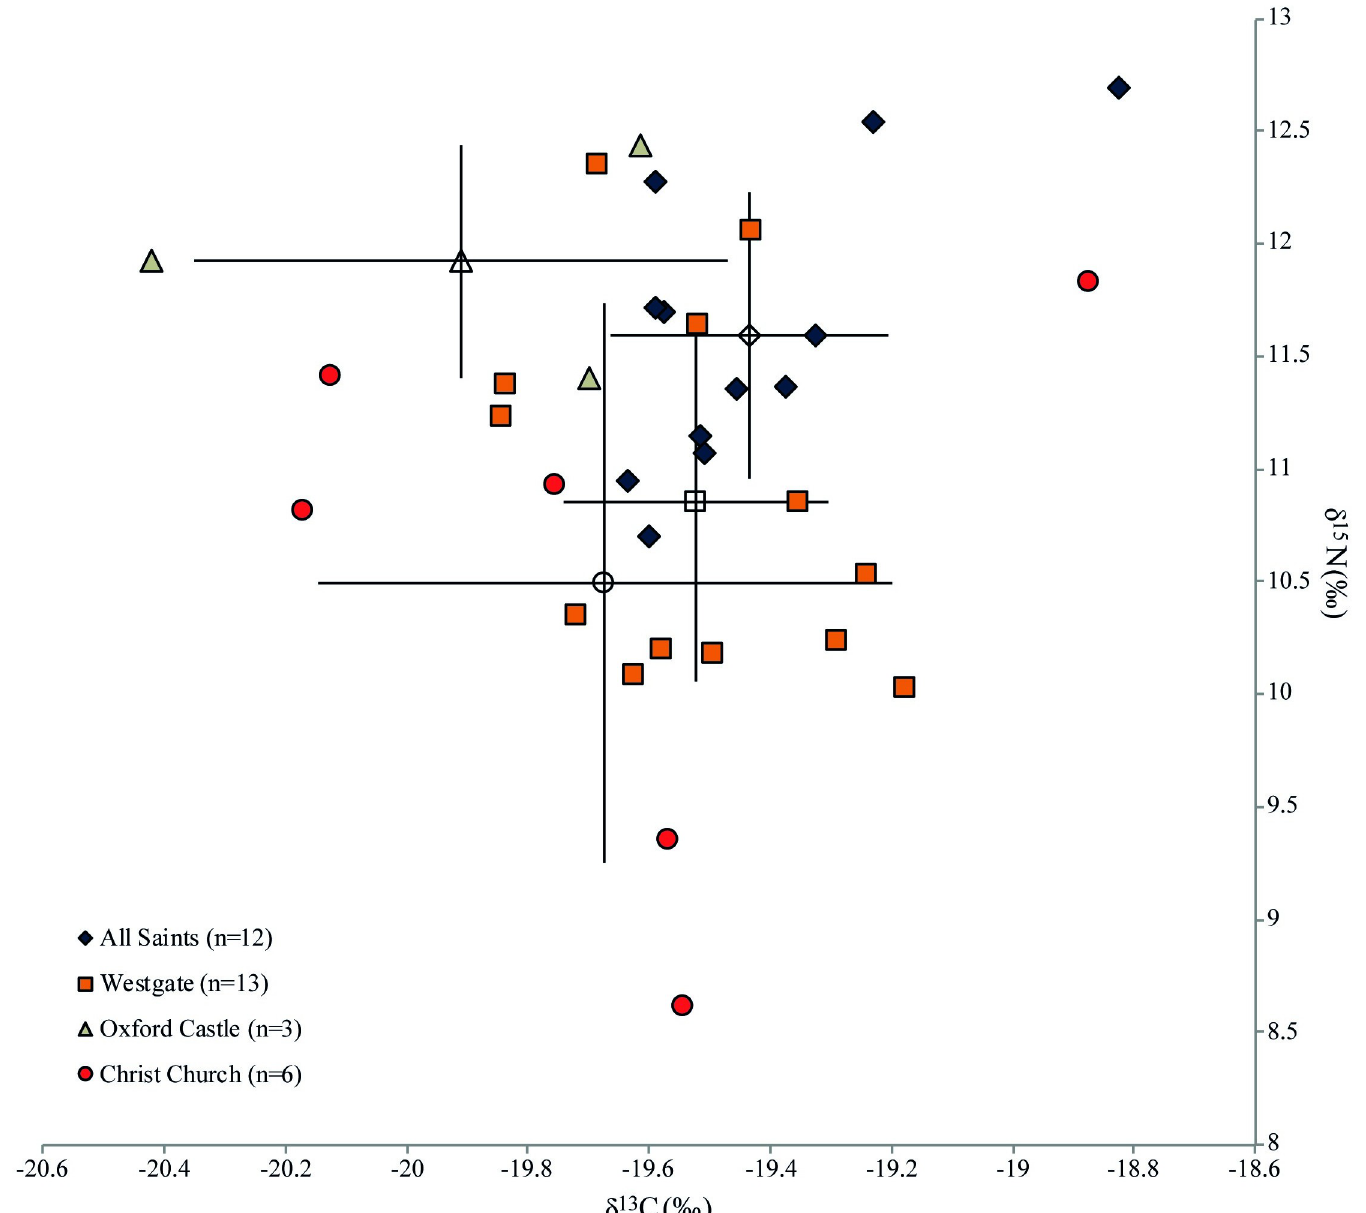
Fig 6. δ 13 C and δ 15 N values from human bone collagen organised by site. Error bars represent one standard deviation.